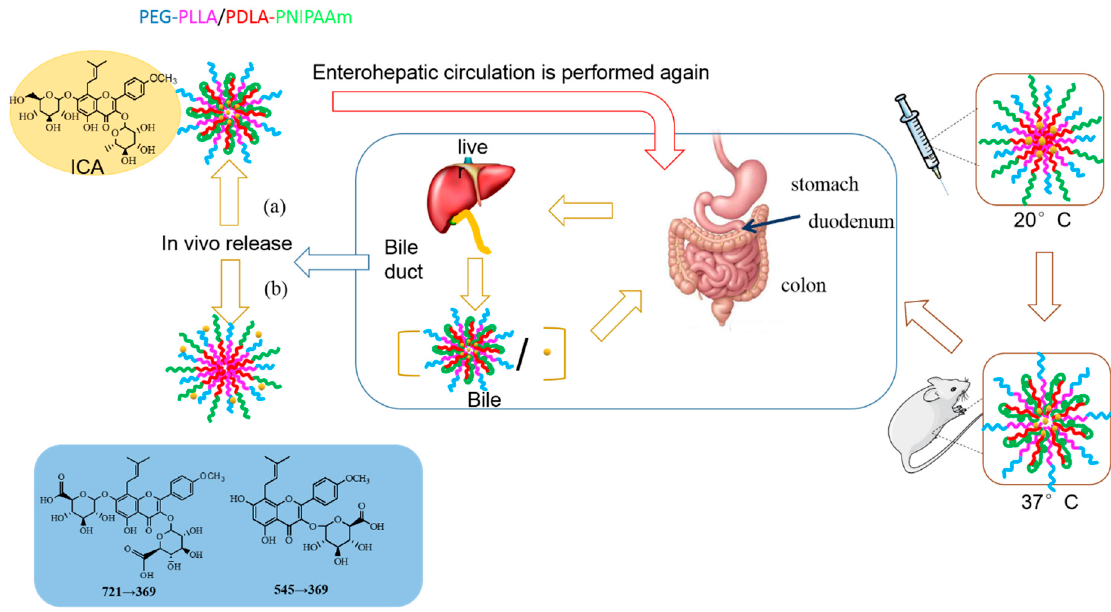
Figure 8. Morphological changes of PEG-PLLA/PDLA-PNIPAM in vivo.